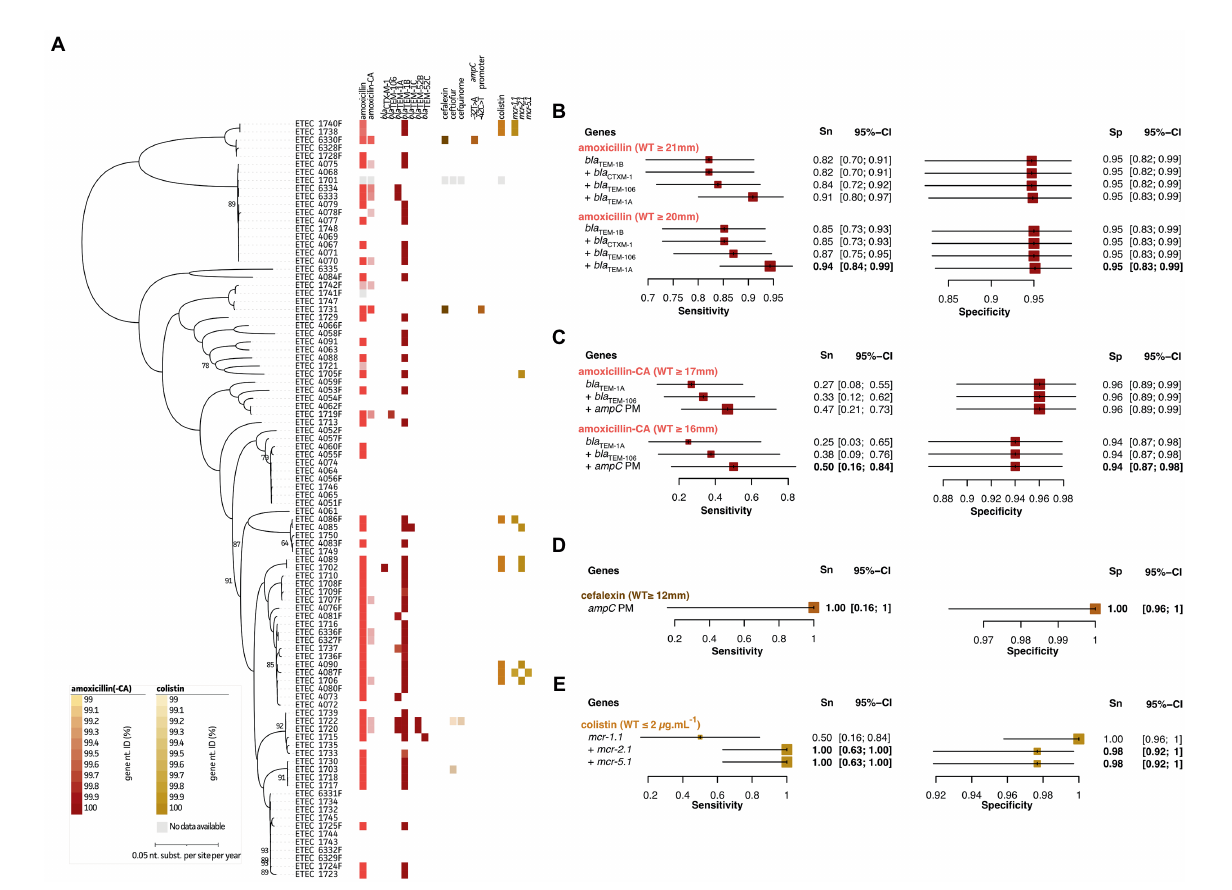
FIGURE 2 Association analyses for phenotypic and genotypic antimicrobial resistance of beta lactams, cephalosporins, and colistin. (A) Maximum Likelihood (ML) tree showing strain relatedness and distribution of resistance phenotypes and genetic markers. Resistance phenotypes are shown based on NRI ECOFF values in which white and colored boxes represent WT and non-WT population, respectively. From left to right; amoxicillin phenotypes, amoxicillin + clavulanic acid (CA) phenotypes, bla genes, cefalexin phenotypes, ceftiofur phenotypes, cefquinome phenotypes, ampC promotor mutations, colistin phenotypes (E-test), and mcr genes. Color grades for genes indicate nucleotide identities (%) as indicated in the legends at the left bottom; (B–E) Forest plots of predictive measures for selected genetic markers and ECOFF diameter cut-offs for the observed phenotypes (disc diffusion diameters (mm) or mg.mL-1 for colistin only). Forest plots show Sensitivity (Sn) and Specificity (Sp) measures and their 95% confidence intervals (CI). Whenever a “+” is indicated, the genetic marker was added to generate the confusion matrix for the